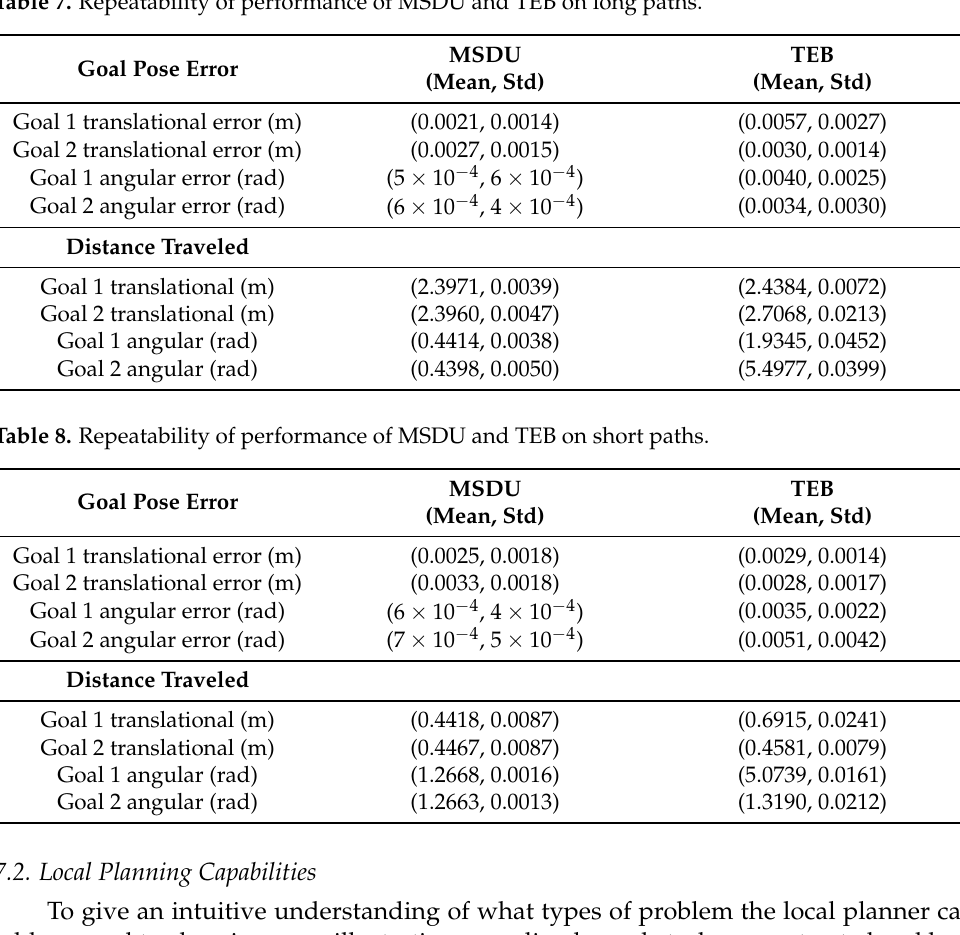
Figure 14. Trajectories taken by the robot during the repeatability experiment. The trajectory of the robot using MSDU is displayed in black, and the robot trajectory using TEB is displayed in red. ( a ) Long path (2.4 m between the two goals); ( b ) short path (0.42 m between the two goals). Table 7. Repeatability of performance of MSDU and TEB on long paths.